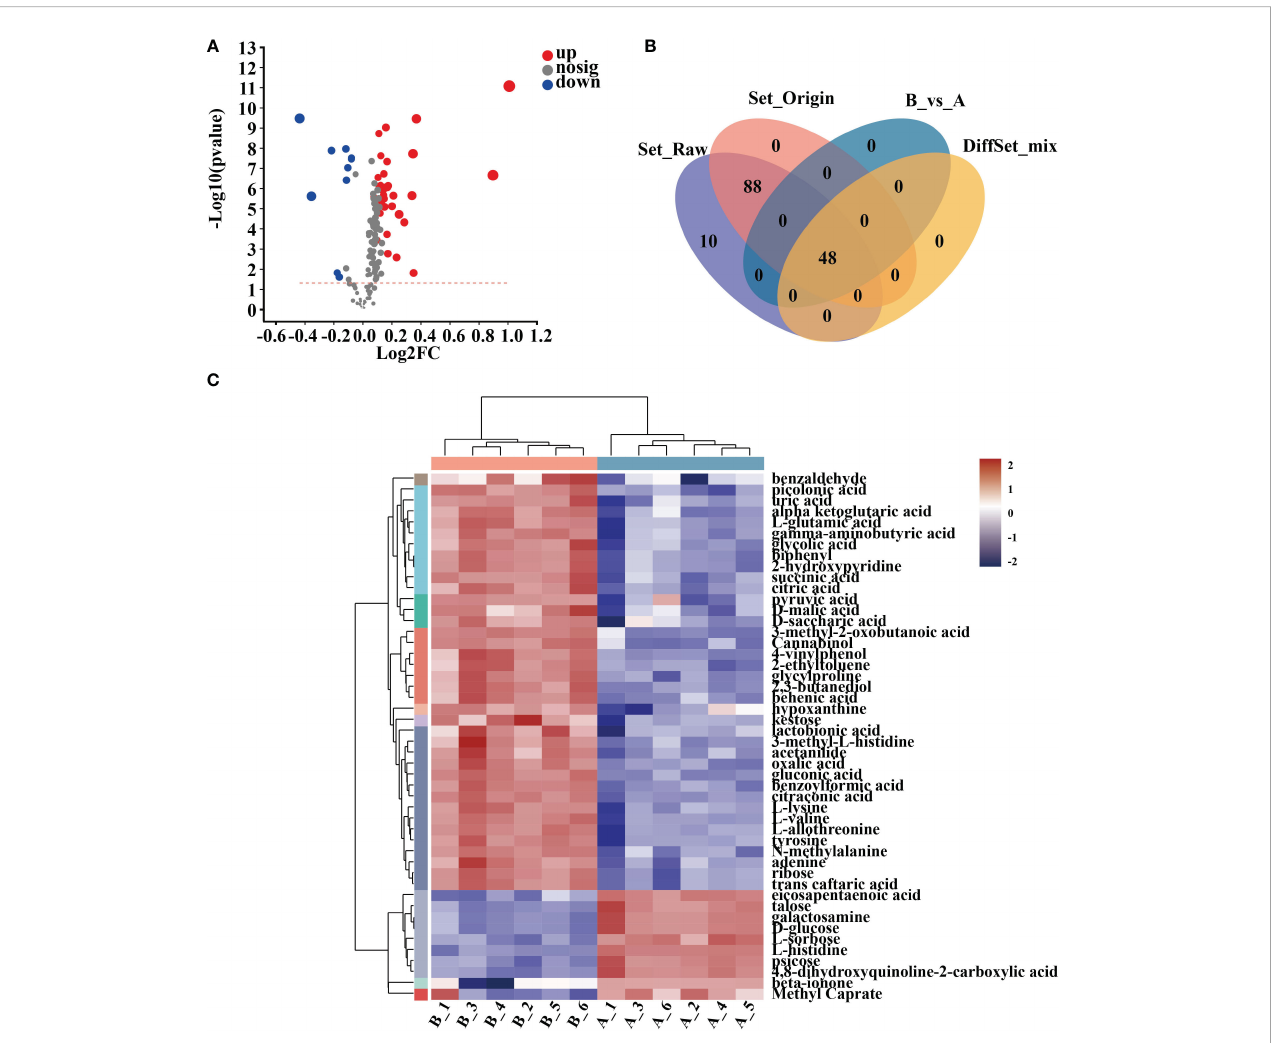
FIGURE 6 Cluster analysis of differential metabolites. (A) Differential metabolite volcano map. (B) Veen map of differential metabolites. (C) Heat map of differential metabolite clustering